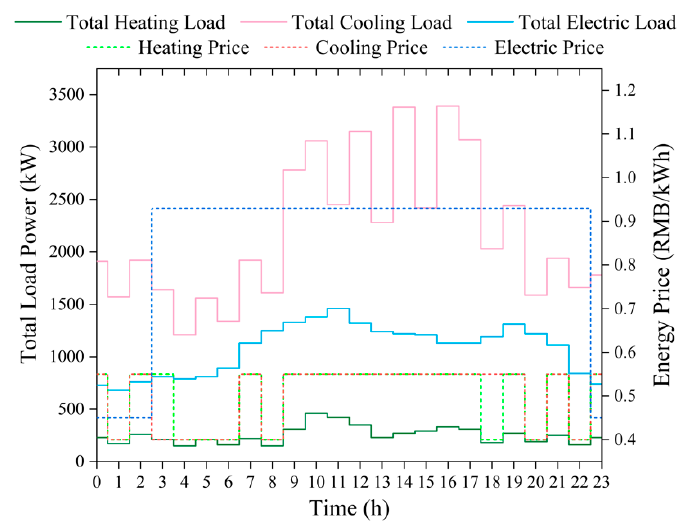
Figure 7. Pricing strategy of operator in case1 in summer.